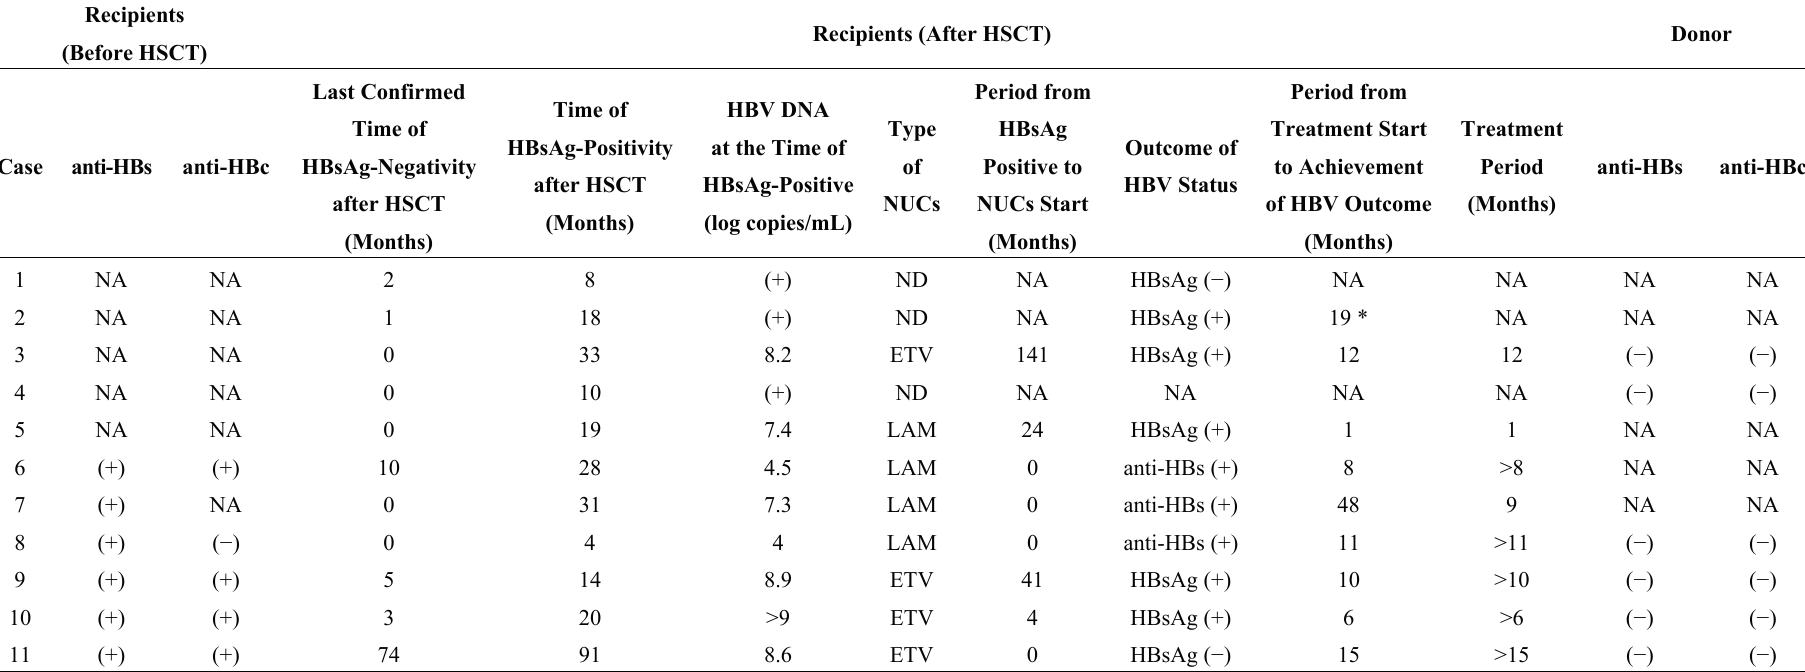
Table 3. HBV status in HBsAg-negative recipients who experienced HBV reactivation after hematopoietic stem cell transplantation (HSCT) and their